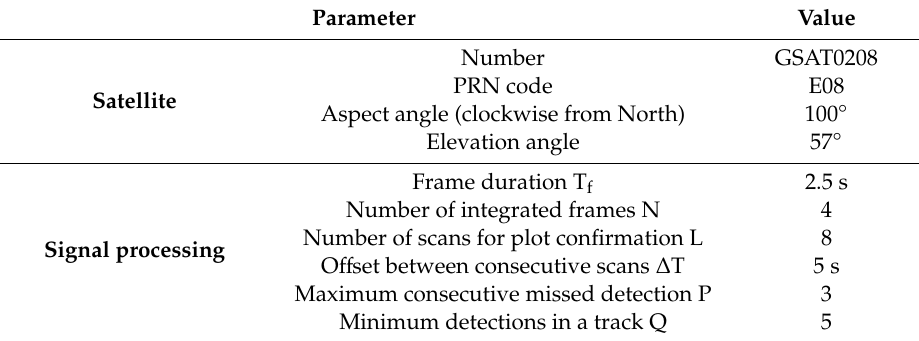
Table 2. Marghera port—experimental and signal processing